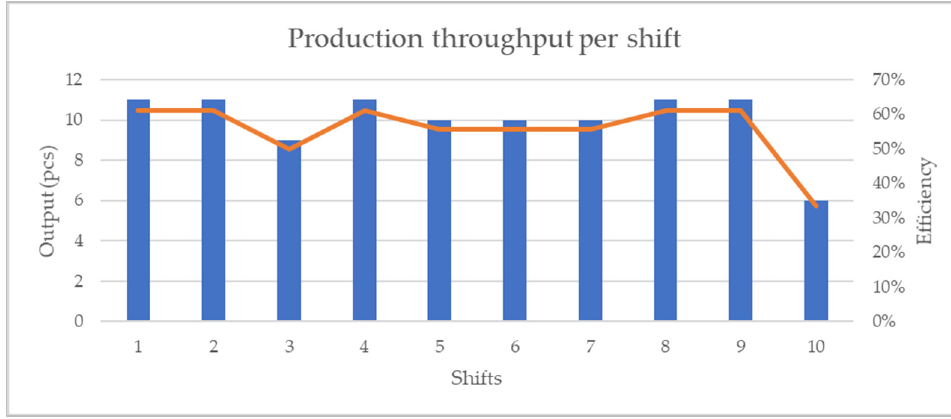
Figure 7. Production throughput per shift.